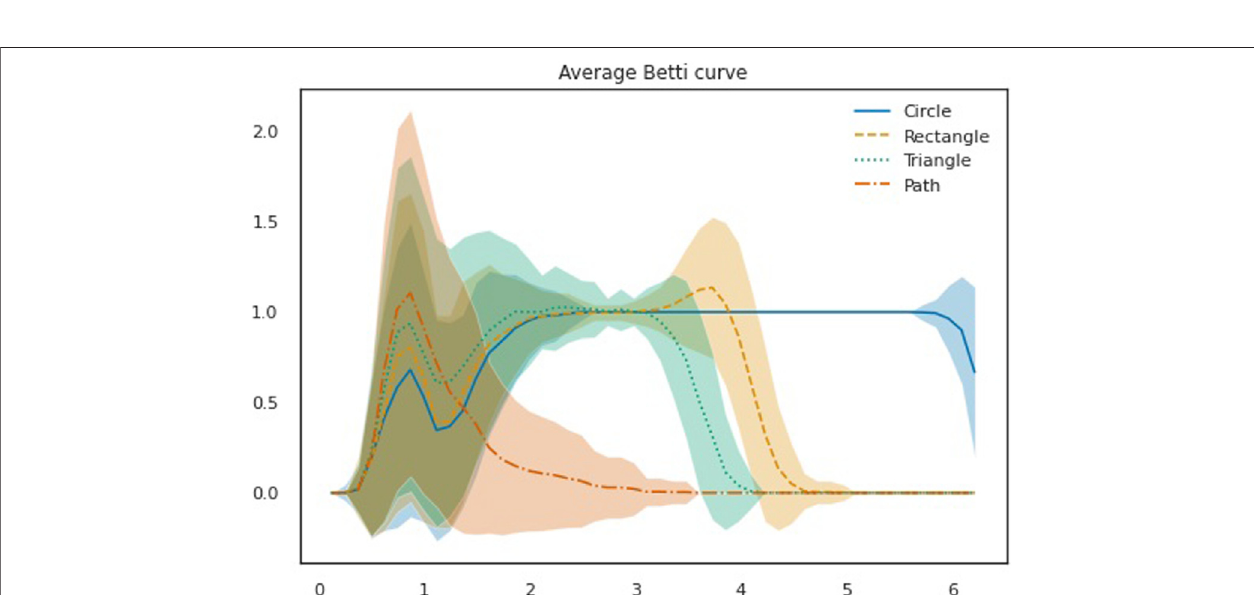
Frontiers in Applied Mathematics and Statistics |